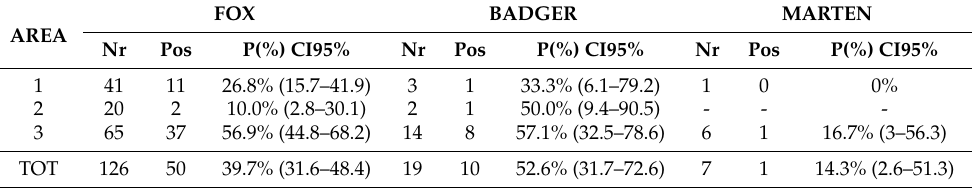
Table 2. Number of animals collected from the three areas and related positive samples (Pos: positive).